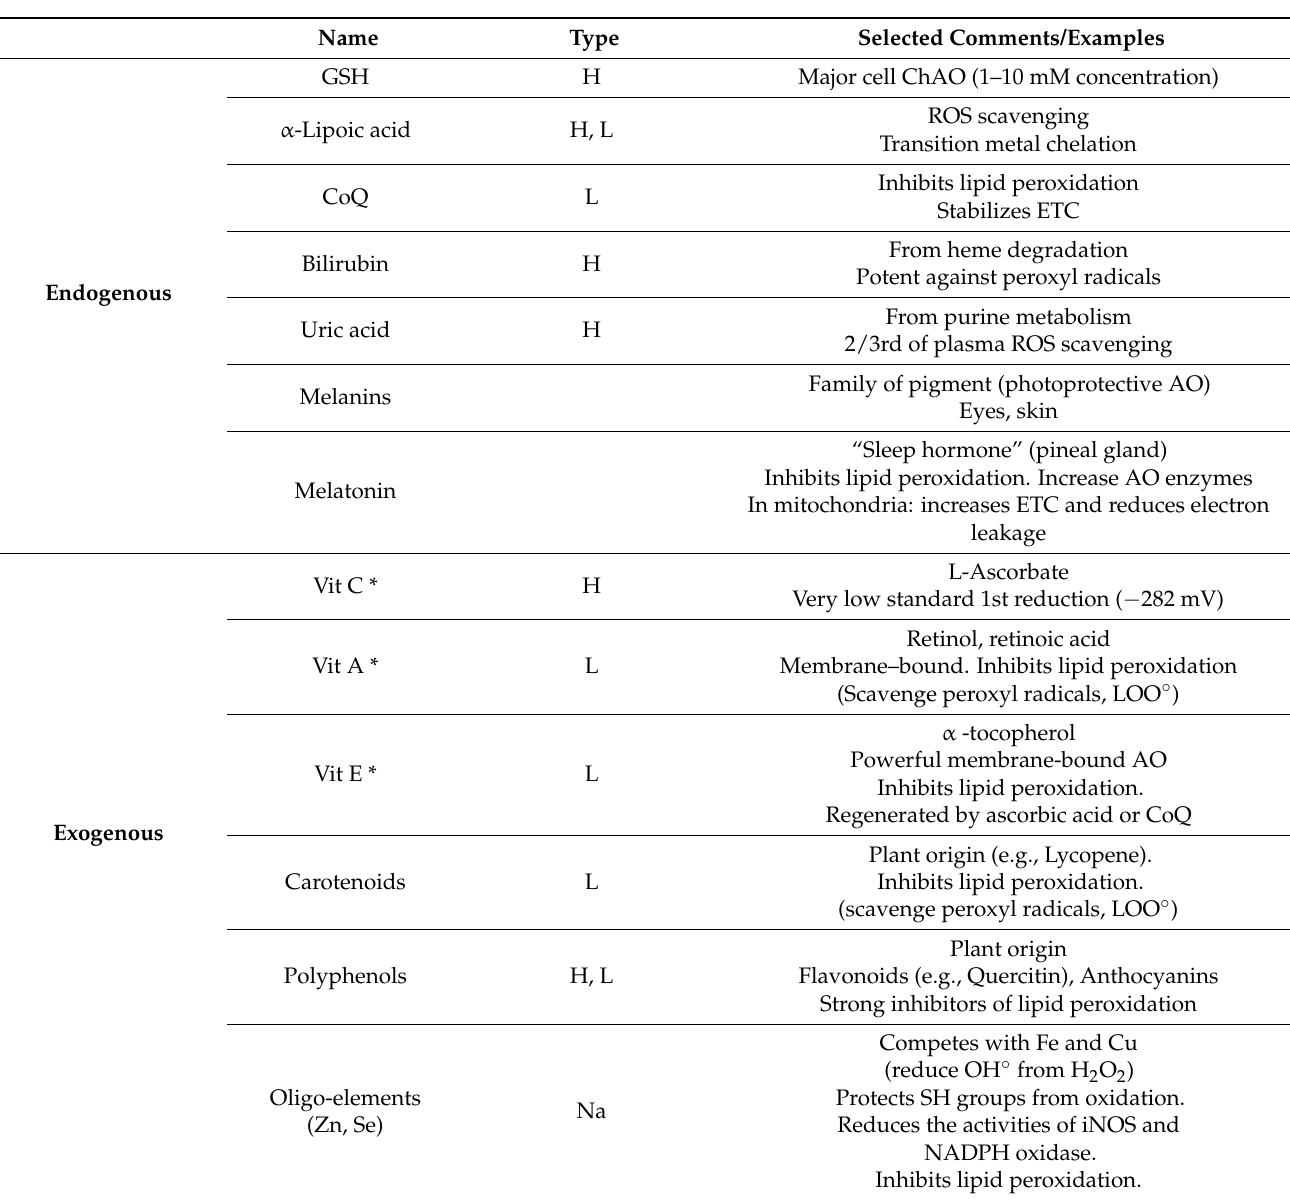
Table 1. Non-enzymatic antioxidant